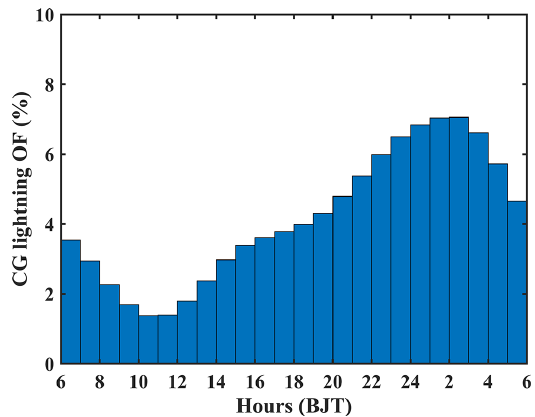
Figure 2. The diurnal variation in the occurrence frequency of lightning flashes (unit: %) over the study region during the summer months (June, July, and August) of